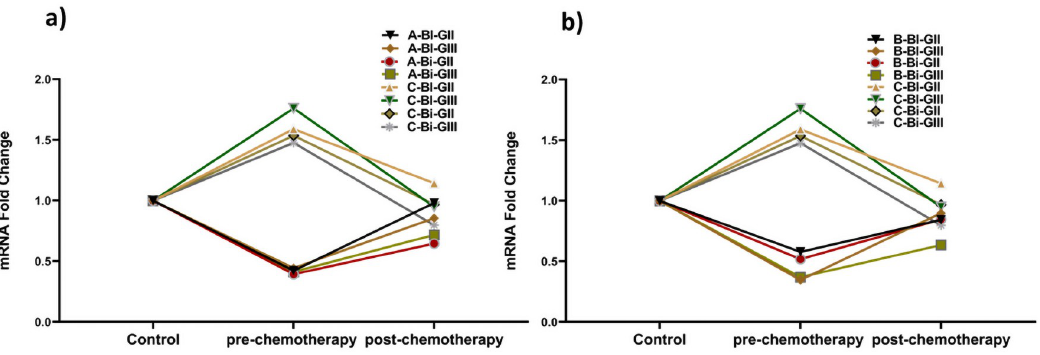
Fig 6. Correlating expression pattern of miRNAs and SMAD2 in breast cancer clinical samples. a) miR-140 b) miR-148a. The results display inverse relation of miRNAs with SMAD2 as in pre-chemotherapy patients downregulated miRNAs cause SMAD2 to upregulate in